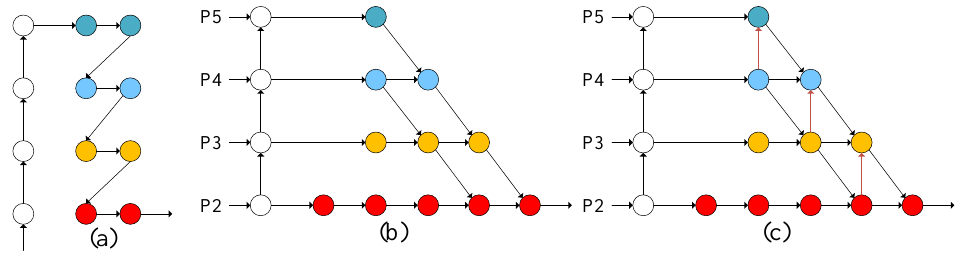
Figure 5. Design of proposed feature networks. ( a ) CenterNet network. ( b ) The proposed multi- scale feature aggregation (MFA) network. ( c ) The proposed CFA network with better accuracy and efficiency